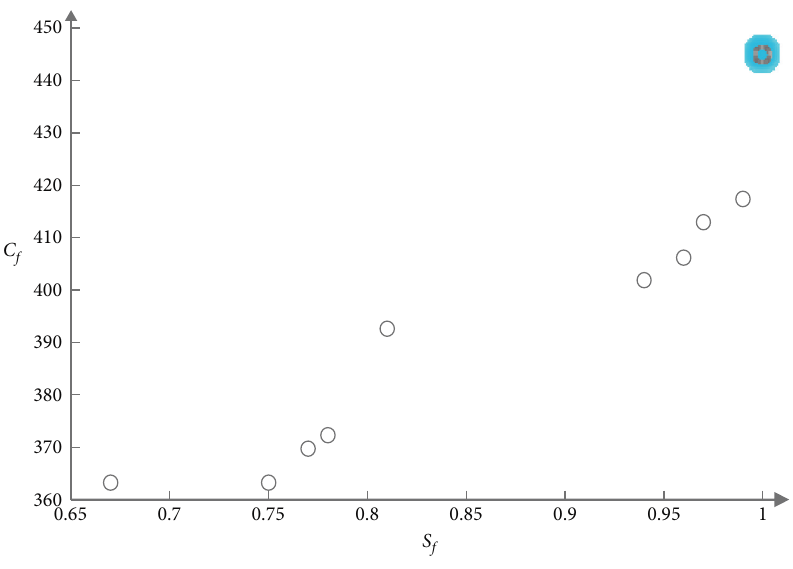
Figure 3: Noninferior solution set of example C105.